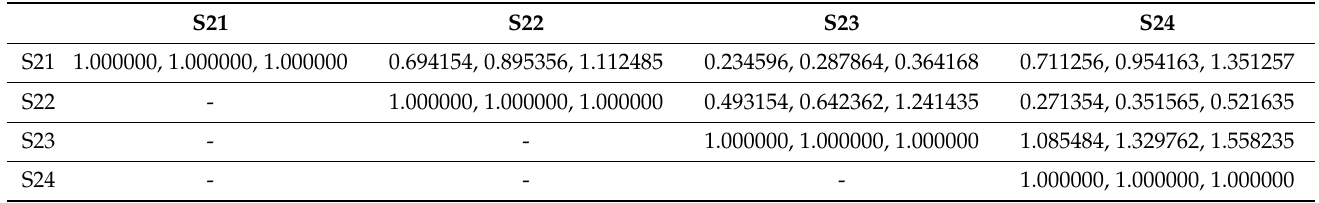
Table 3. The fuzzy-aggregated pairwise comparison matrix at Level 2 for